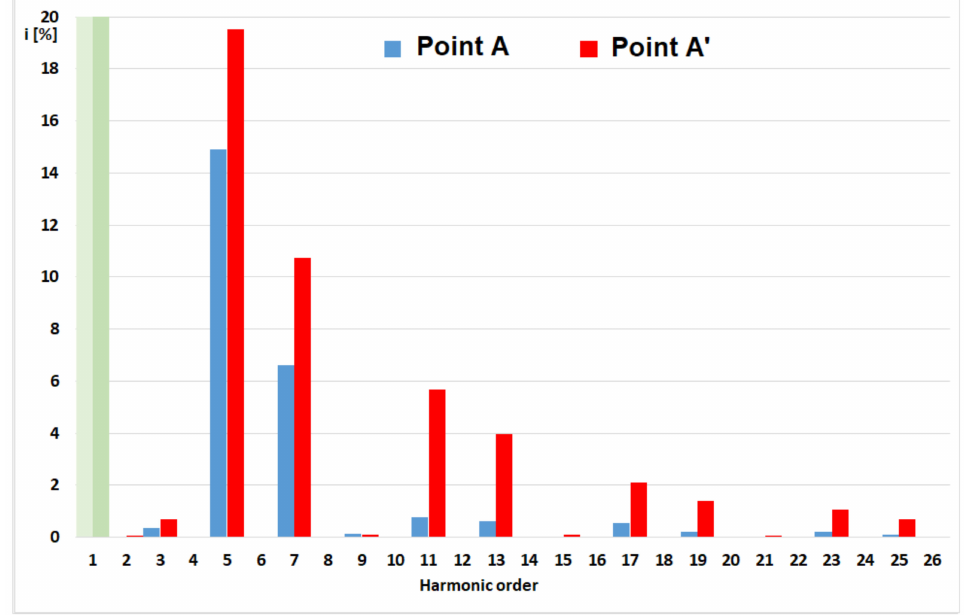
Figure 8. Spectrum of current harmonics—point A and point A (cid:48) . Distorted current causes voltage distortion. Figure 9 shows spectrum of voltage harmonics measured at point A and point A (cid:48) . The values of individual voltage